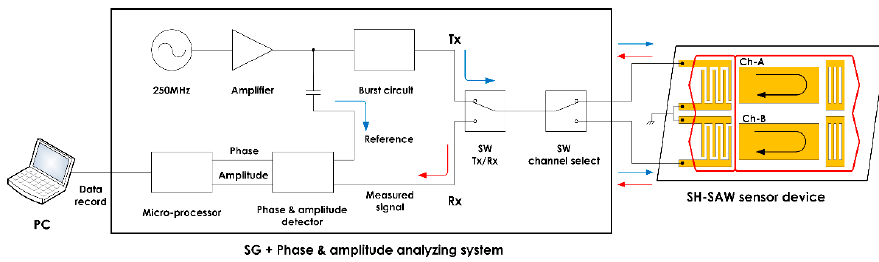
Figure 2. Block diagram of the measurement system.